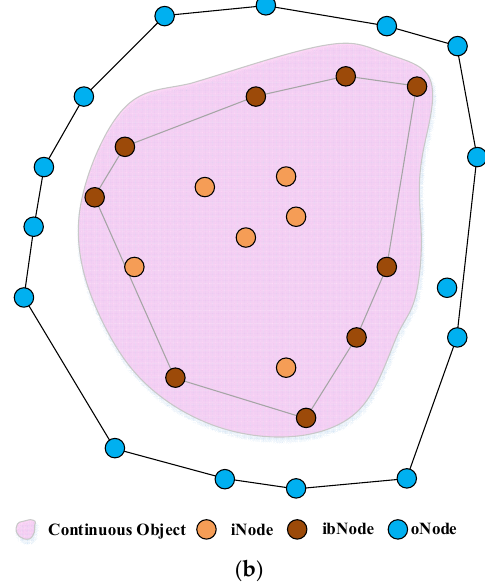
Figure 2. The continuous object’s rough area is sketched by MCH. ( a ) The sensors included in the set of iNode are involved in finding their convex hull. The sensors used to construct this convex hull are the inner boundary nodes. ( b ) The sensors included in the set of oNodes are involved in finding their convex hull. The sensors used to construct this convex hull are the outer boundary nodes. The practice boundary of the continuous object is enclosed by the two convex hull polygons built with the sensors in iNode and oNode.